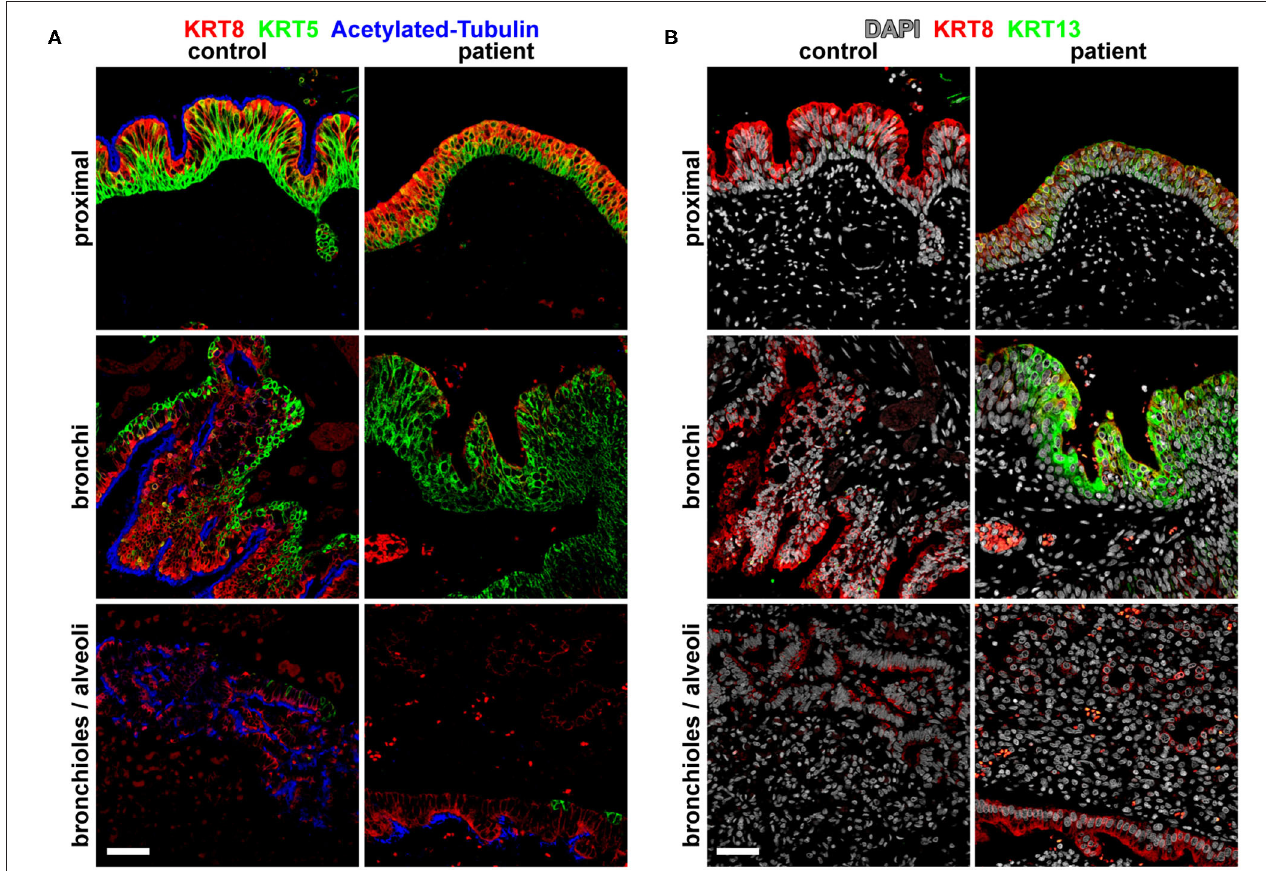
FIGURE 3 | Molecular analysis for differentiation markers of the broncho-esophageal fistula and more distal airways. (A) Immunofluorescence staining for cytokeratins KRT5 and KRT8, as well as acetylated tubulin in sections from the proximal epithelium (broncho-esophageal fistula vs. trachea, respectively), bronchi, and distal bronchioles and alveoli. (B) Immunofluorescence staining for cytokeratins KRT8 and KRT13 in sections from the proximal epithelium (broncho-esophageal fistula vs. trachea, respectively), bronchi, and distal bronchioles and alveoli. Scale bars represent 50 µ